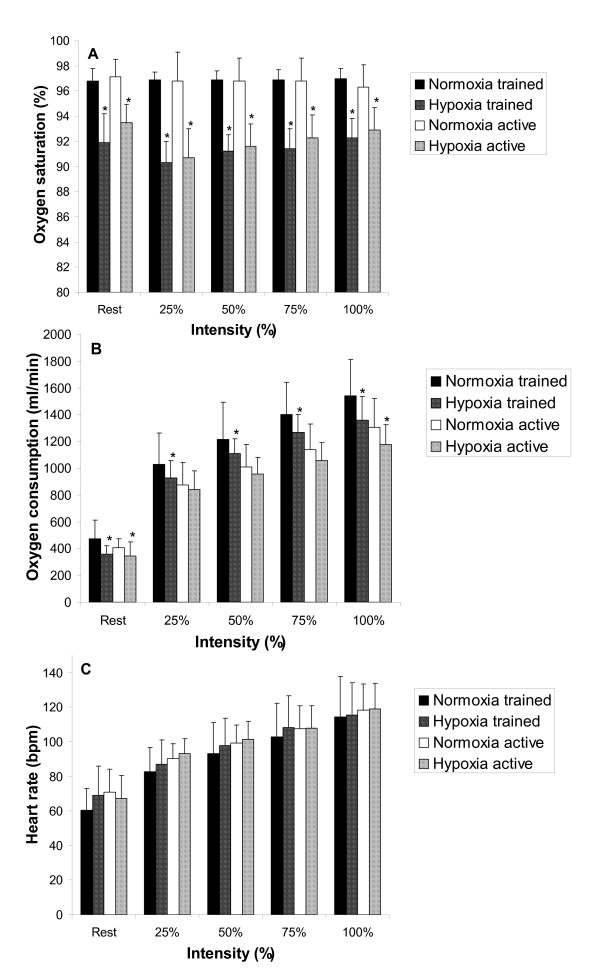
Comparison of oxyhemoglobin saturation (Panel A), oxygen consumption (Panel B) and heart rate (Panel C) for trained and active groups at each intensity of exercise. * means significantly different normoxia (p < 0.05).